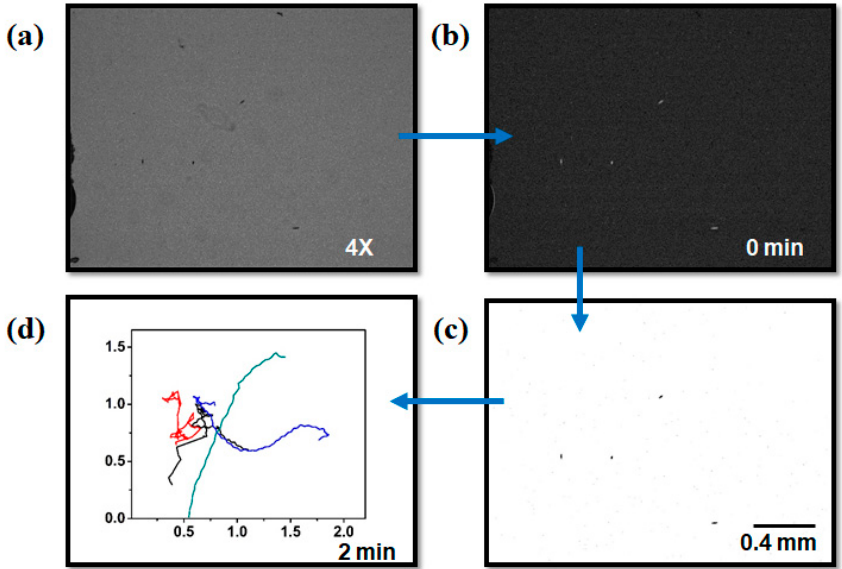
Figure 2. Image processing steps. ( a ) 4× magnified image of microswimmers at the original concentration; ( b ) Subtracted background; ( c ) The binarized image that separates the microswimmers from the background; and, ( d ) Microswimmer trajectory from a stack of images that were captured continuously for 2 min with an interval of 1 s. (Scale bar = 0.4 mm).